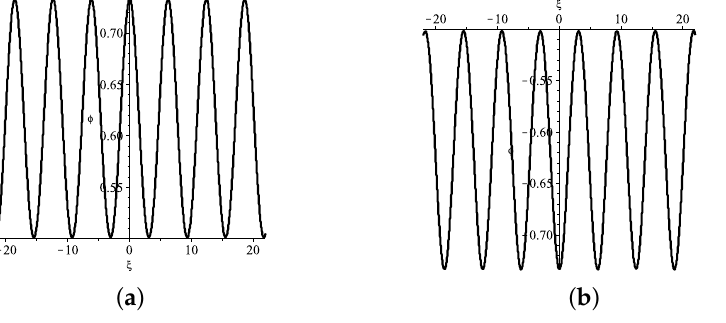
Figure 20. Periodicwave forms of system (5). ( a ) Defined by (54) + . ( b ) Defined by (54) − .